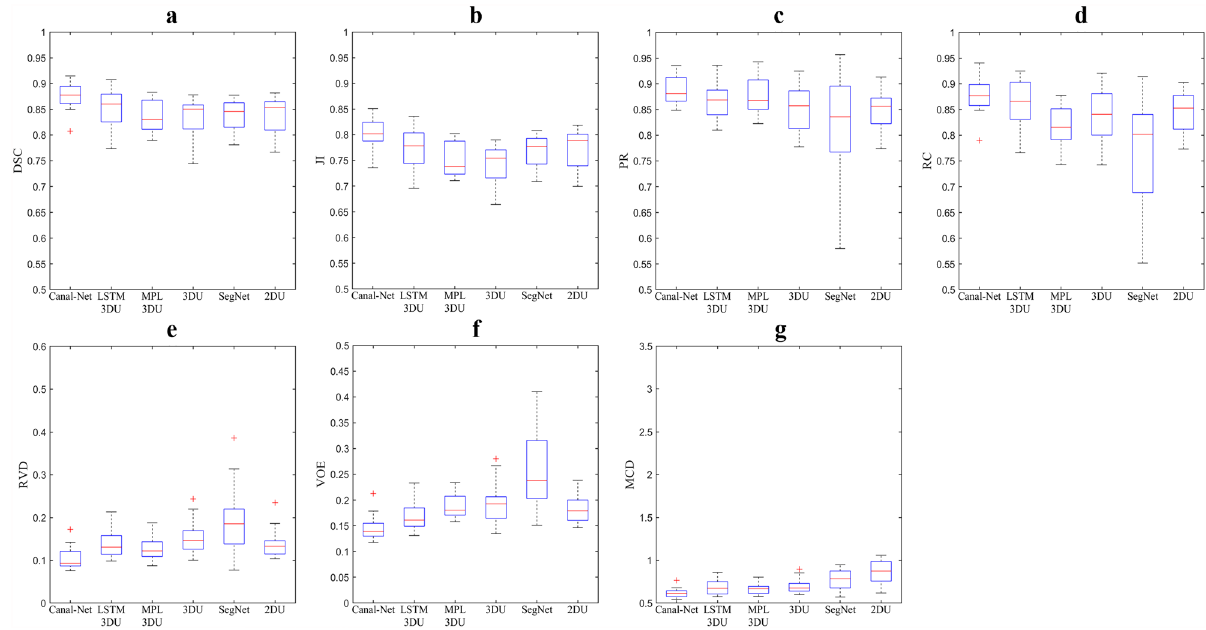
Figure 2. The boxplots of segmentation performance results of the ( a ) Dice similarity coefficient score (DSC), ( b ) Jaccard index (JI), ( c ) precision (PR), ( d ) recall (RC), ( e ) relative volume difference (RVD), ( f ) volume of error (VOE), and ( g ) mean curve distance (MCD) for the deep learning networks, Canal-Net, ConvLTSM 3D U-Net (LSTM 3DU), MPL 3D U-Net (MPL 3DU), 3D U-Net (3DU), SegNet, and 2D U-Net (2DU). Each box contains the first and third quartile of data. The medians are located inside of the boxes, visualized as red lines. The whiskers are extended above and below each box in ± 1.5 times the interquartile range (IQR), and the outliers are visualized as red + marks defining values 1.5 IQR away from the and demonstrated improved structural continuity and boundary details of the MC from the mental foramen to the mandibular foramen compared to the other networks (Fig. 4a–e). The DSC and MCD for the whole test dataset were plotted from the mental foramen to the mandibular fora- men, and the 3D networks generally exhibited less variations of the performances compared to the 2D networks (Figs. 5 and 6). The Canal-Net demonstrated the most consistent performances with the smallest fluctuations of true segmentation compared to the other networks throughout the entire MC volume (Figs. 5 and 6). As a result, the Canal-Net represented the best 3D segmentation accuracies of RVD, VOE, and MCD throughout the entire MC volume among the networks (Table 2). The Bland–Altman plot between the ground truth and predic- tion results from the Canal-Net showed higher linear relationships and better agreement limits than those from the other networks (Fig. 7). Therefore, the Canal-Net represented more accurate and robust MC segmentation performance of the entire MC compared to the other networks.